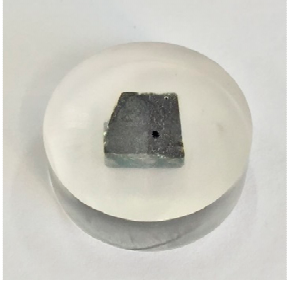
Figure 6. The specimens of the nanoindentation